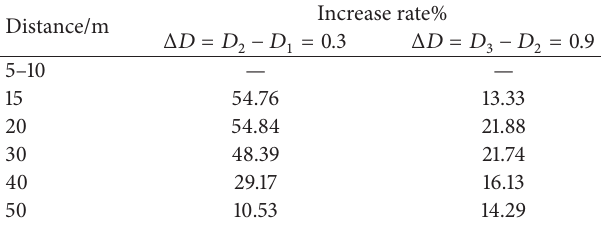
Figure 5: Comparison of overpressure under various diameters versus different